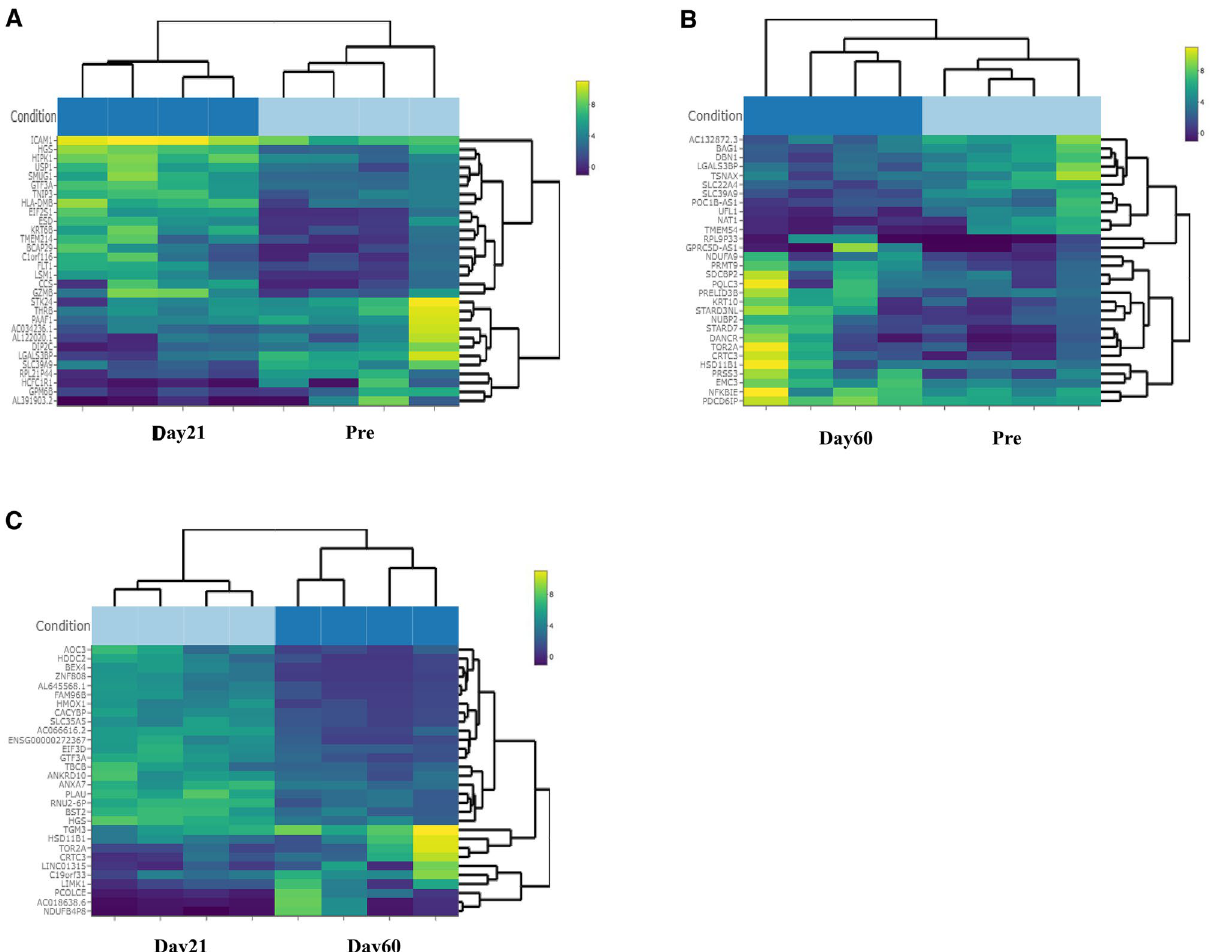
Figure 3. ( A – C ) A bi-clustering heatmap showing the visual expression profile of the top differentially expressed genes sorted by their adjusted p-value by plotting their log2 transformed expression values in samples (generated by using the Wald test). ( A ) shows the pre- versus D21 comparison where we observed 10 differentially expressed genes, out of which nine were upregulated and one was downregulated. ( B ) shows pre-versus D60 comparison, we saw five differentially expressed genes; one was downregulated and four were upregulated. ( C ) shows the last comparison between D21 versus D60, there were a total of 50 differentially expressed genes out of which 32 were downregulated and 18 were